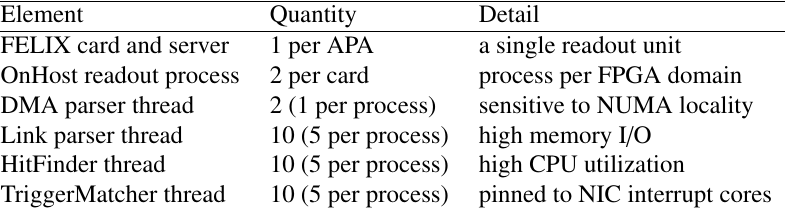
Table 1. Processes and threads on FELIX host